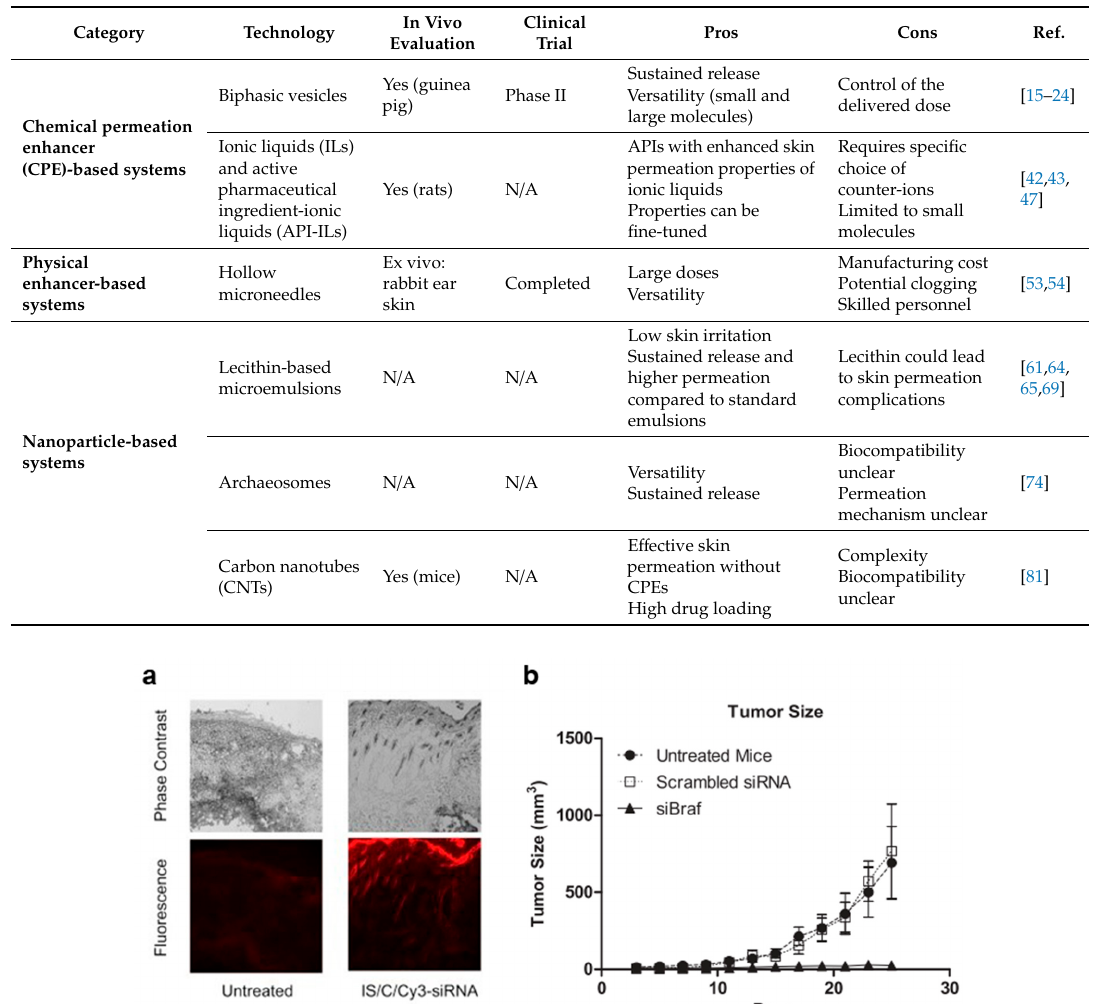
Table 1. Transdermal drug delivery systems covered in the review.